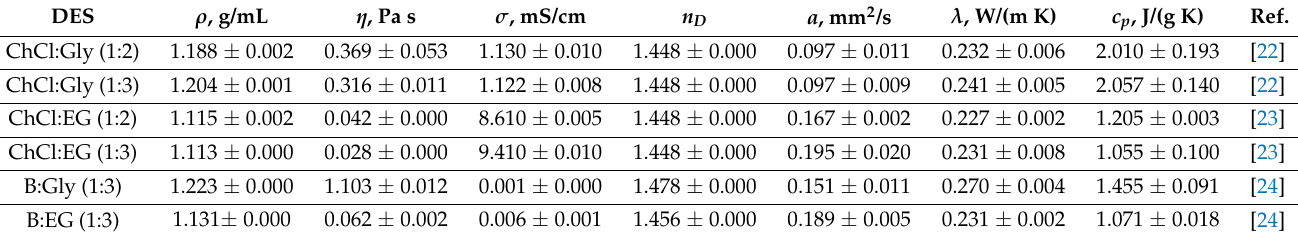
Table 2. Properties of selected DESs at 25 ◦